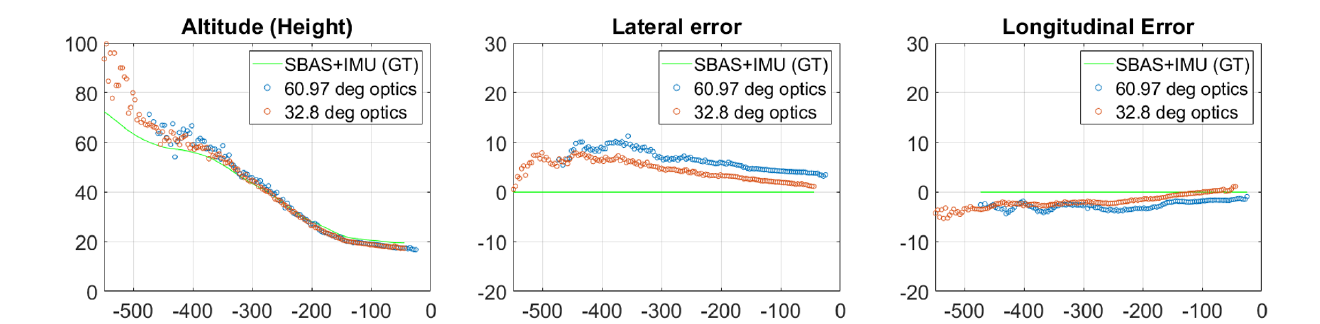
Figure 19. Measurements of relative positions with different optics during approach 3 of the Septfonds flight